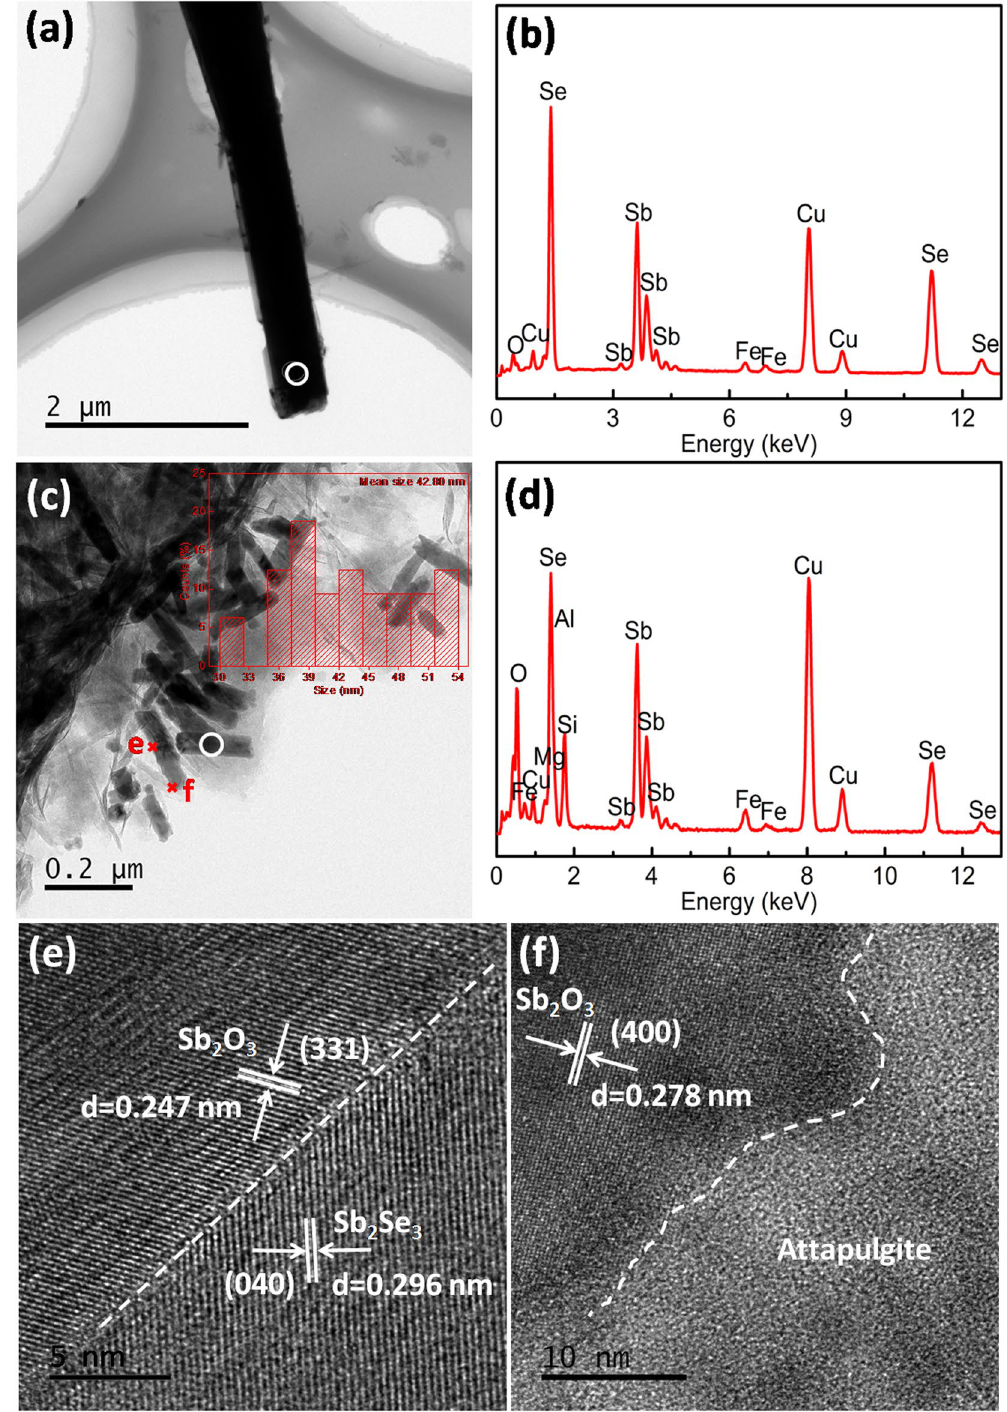
Figure 4. ( a,c ) TEM images, the inset showed the corresponding size distribution diagram, ( b,d ) EDS and ( e,f ) HRTEM images of Sb 2 Se 3 /Sb 2 O 3 @attapulgite corresponded to the indicating region in ( c